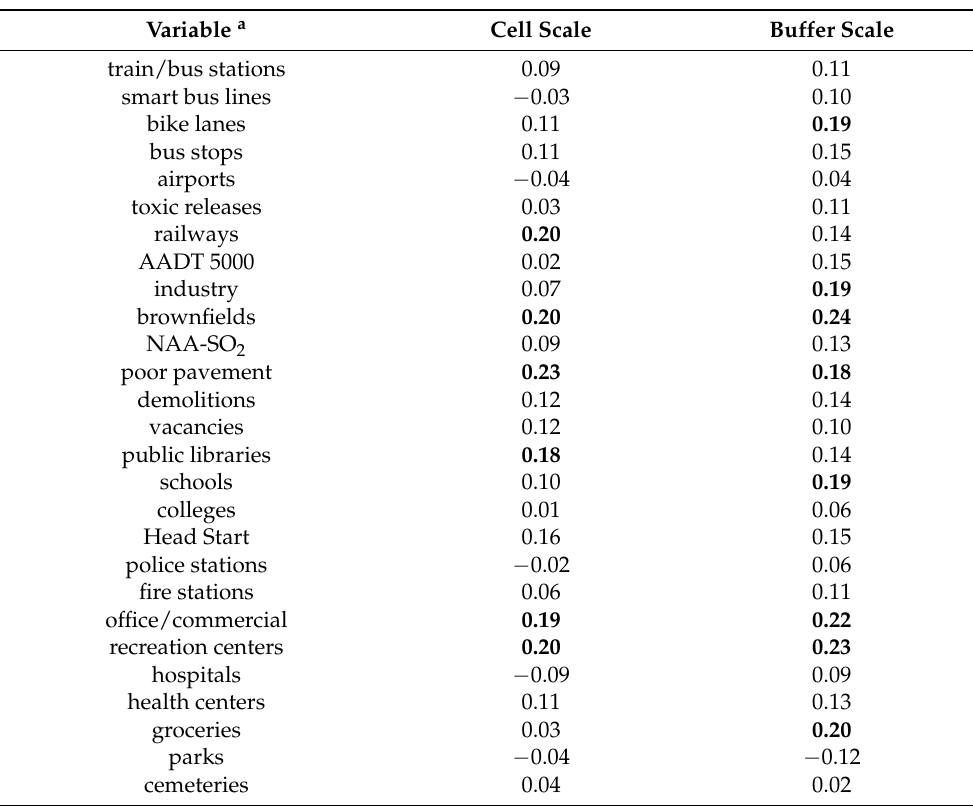
Table 3. Spearman correlation of the difference in median household income (DMHI) between 2017 and 2013 with potential explanatory variables at the cell and buffer